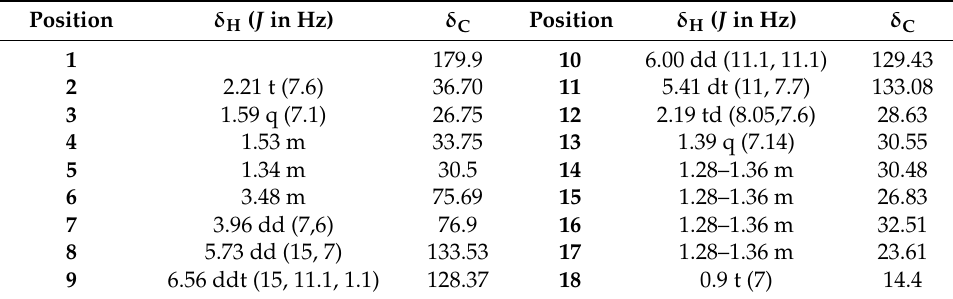
Figure 3. Structure and selected NMR correlations of ε -caprolactone derivative. Table 3. 1 H- and 13 C- NMR chemical shifts of ε -caprolactone derivative.